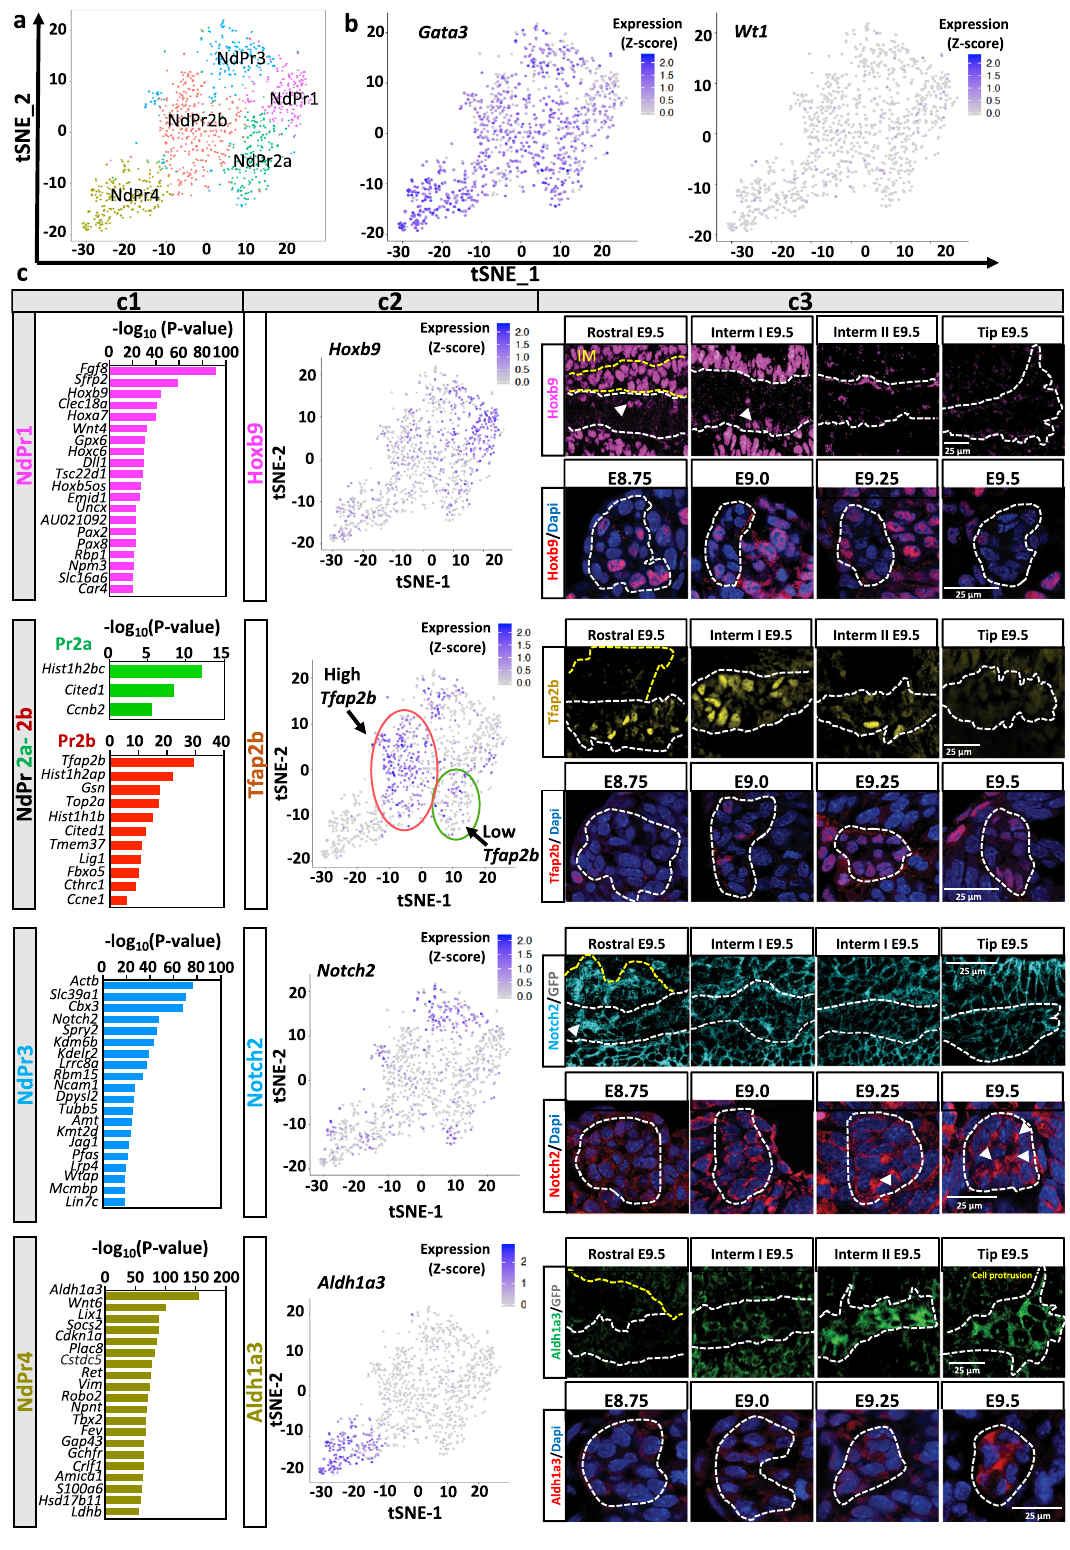
connecting duct cells and the Aldh1a3 + cell population (Fig. 4e and f, t = 0 h). NdPr2 expressing grafts were implanted near the rostral or caudal ND (Fig. 4d, e, f) of wild type embryos to assess their differentiation potential. After 24 h in culture rostral grafts acquired a NdPr3 fate (Fig. 4e). Conversely, NdPr2 explants